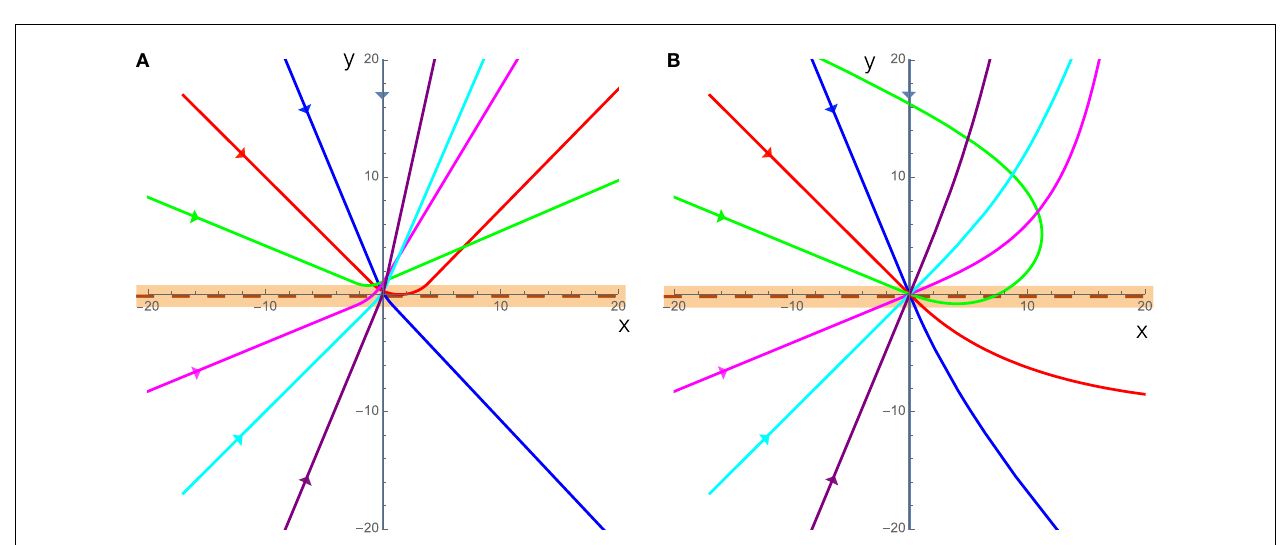
Frontiers in Materials |